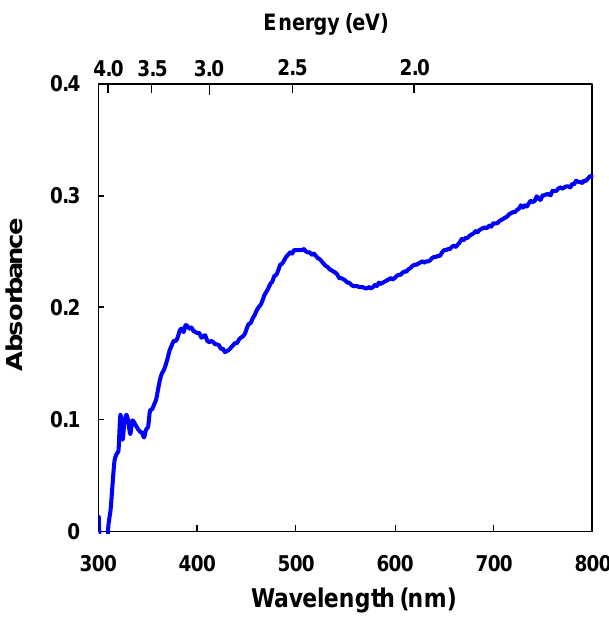
bulk heterojunction solar 60